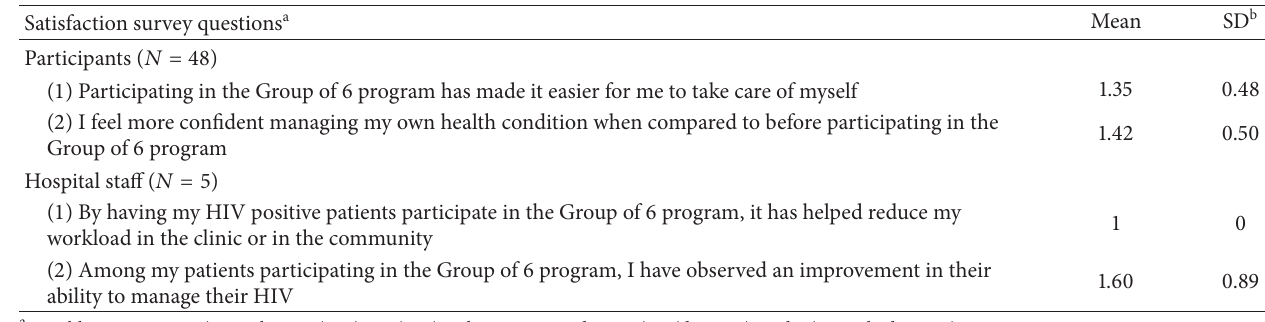
Table 2: Responses to participant and hospital staff satisfaction